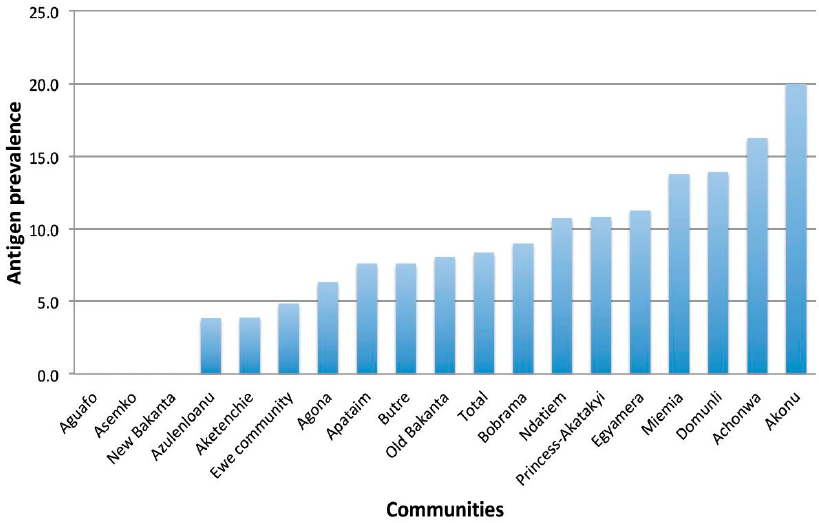
Figure 1. Prevalence of W. bancrofti antigen among study participants as categorized by communities.